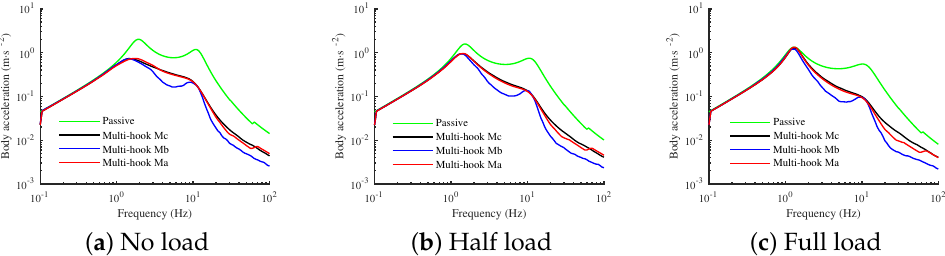
Figure 4. Comparison of body acceleration RMS values between the passive suspension and the semi-active suspensions with the multi-hook controls under different loads. Table 6. Resonant frequencies and peak RMS values of body acceleration for the passive suspension and the semi-active suspensions with the double-skyhook controls under different